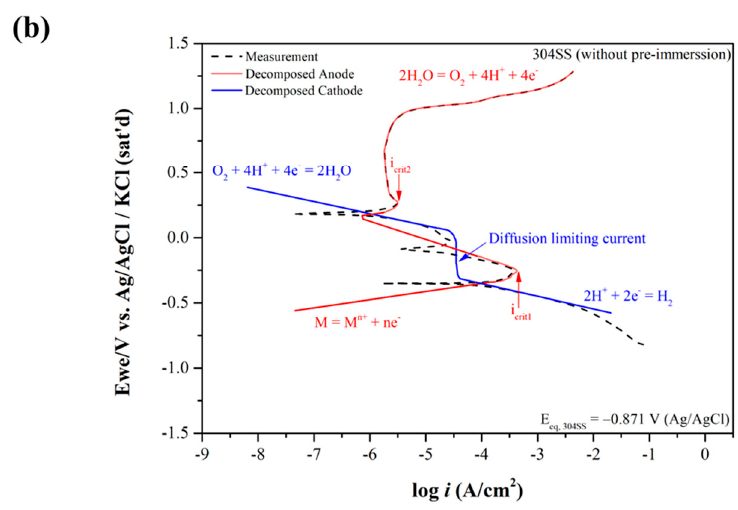
Figure 2. The anodic curves and cathodic curves decomposed from Figure 1 for ( a ) CoCrFeNi HEA and ( b ) 304SS.